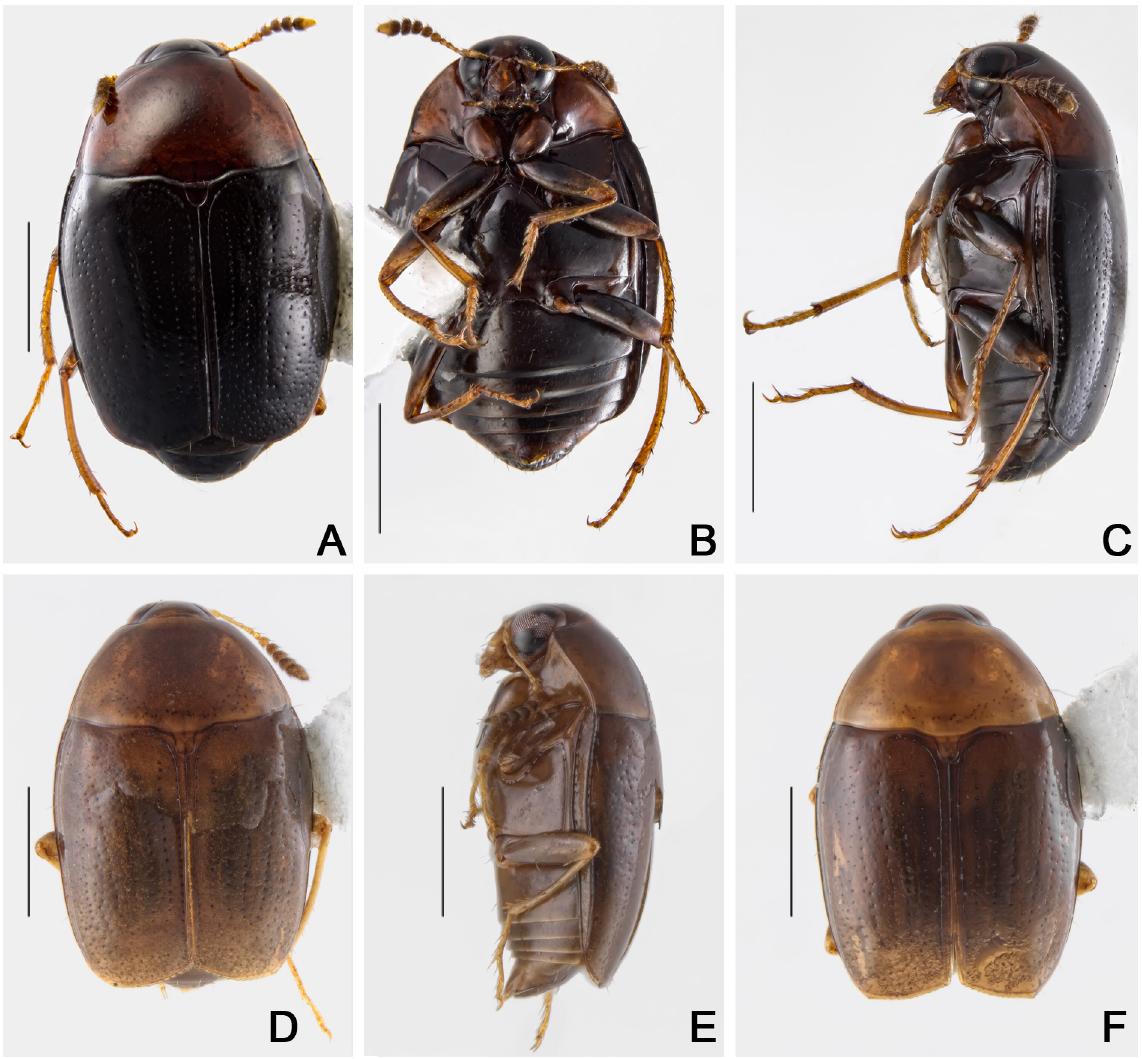
Fig. 47. Cyparium collare Pic, 1920. A–C . ♂ (CELC). A . Dorsal view. B . Ventral view. C . Lateral view. D–F . ♀ (CELC). D . Dorsal view. E . Lateral view. F . Dorsal view. Specimens collected at Mata